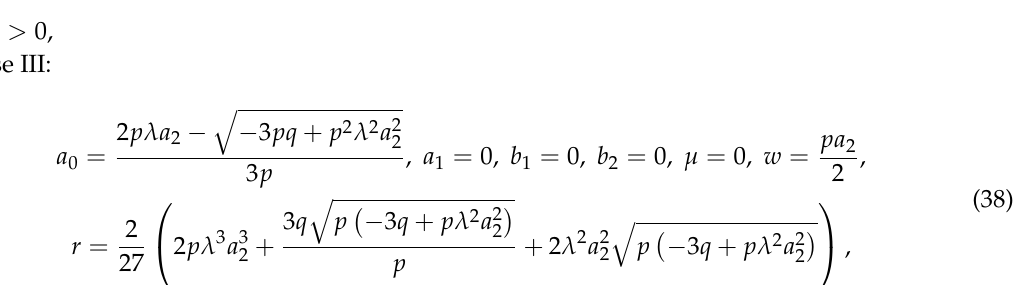
Figure 4. 3D, contour and 2D graphs respectively for λ = − 1, c 2 = 2, c 1 = 5, q = − 5, r = 3 values of Equation (37).